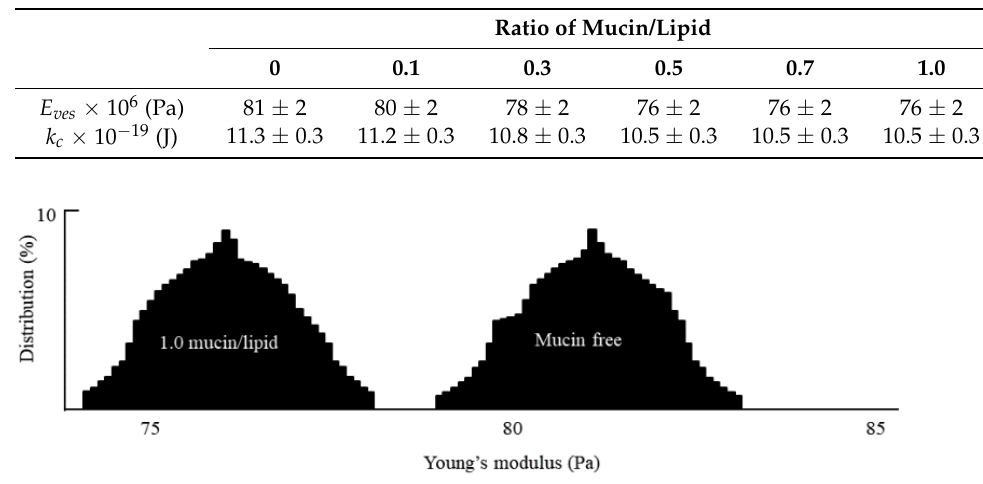
Figure 4. Distributions of both moduli for 1.0 mucin/lipid ( left ) and 0 mucin/lipid ( right ).